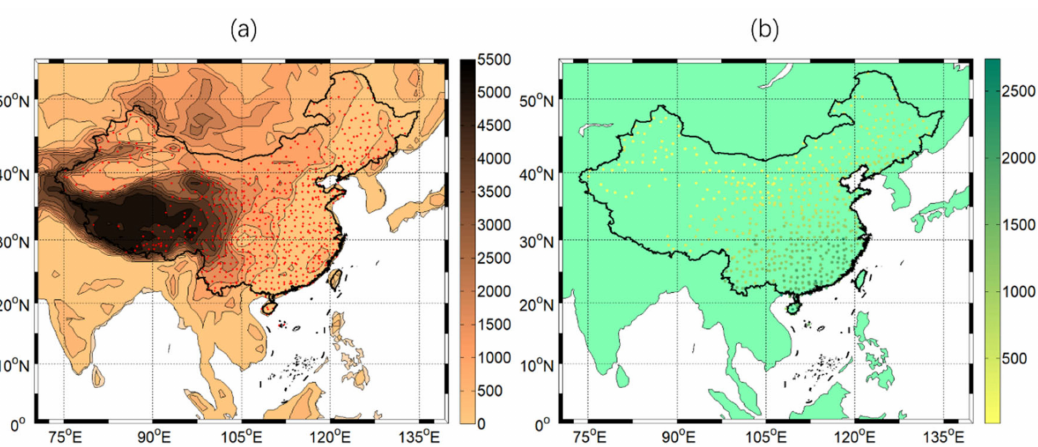
Figure 1. Analysis domain: ( a ) topography and station distribution; contour lines indicate elevation (m), and red dots represent the location of weather stations; ( b ) the average annual precipitation (mm/year) for each